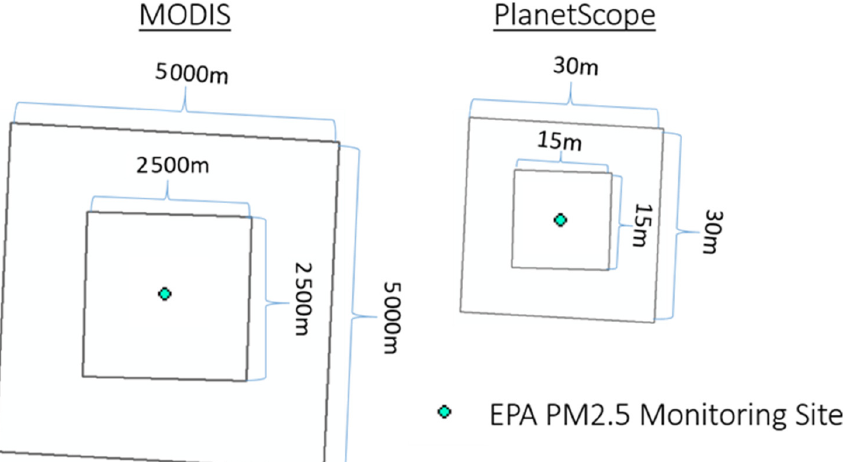
Figure 2. Schematic illustrating the 5 × 5 and 10 × 10 pixel size averages utilized for the TOA reflectance comparison between PlanetScope and MODIS. The inner boxes represent the 5 × 5 pixel average, whereas the outer boxes represent the 10 × 10 pixel averages (MODIS to the left and PlanetScope to the right). The difference in size between the MODIS (left) and PlanetScope (right) boxes are not to scale. TOA reflectance was averaged over an area surrounding each PM 2.5 monitoring site, at two different scales, in order to account for noise in the imagery, and to investigate the effect of scale on the average reflectance value. PM 2.5 readings at the EPA AQS monitoring sites used in this study are taken each hour. To account for spatial gradients in the PM 2.5 value, the PM 2.5 concentrations were averaged over a three-hour window centered as closely as possible to the respective PlanetScope and MODIS image acquisition times. A total of 41 data points were collected, where a data point consists of the 5 × 5 and 10 × 10 averaged TOA reflectance (cen- tered around a PM 2.5 station) for an overlapping PlanetScope and MODIS image pair, and the corresponding three-hour averaged PM 2.5 concentrations.